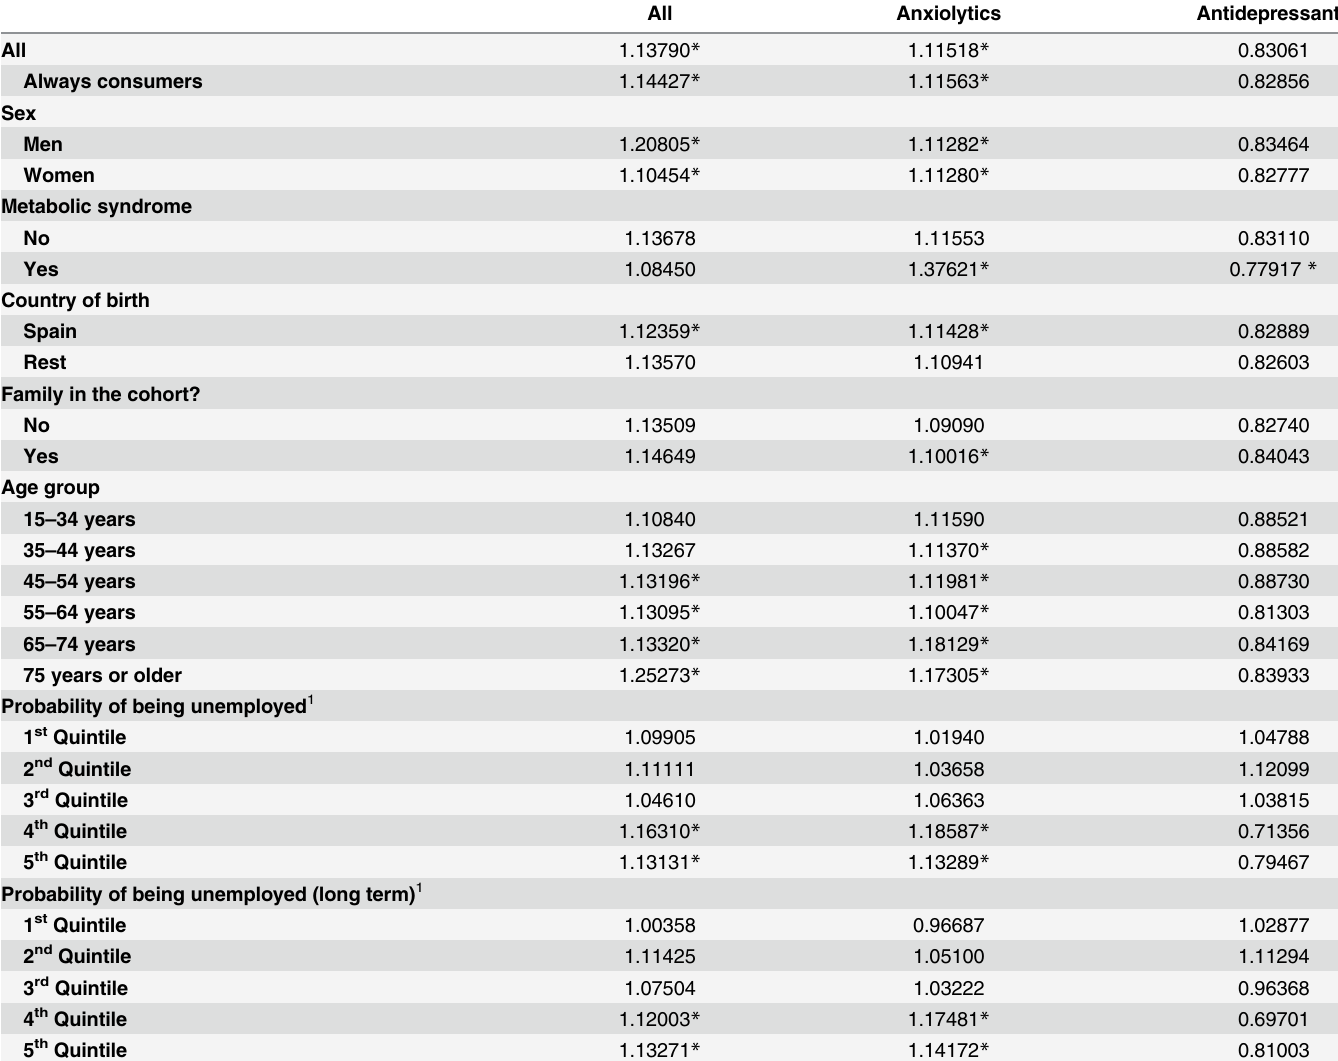
Table 6. Multivariate analysis. Increase in the number of drugs (per individual/month). Relative risk 2009 – 2012 vs. 2005 –